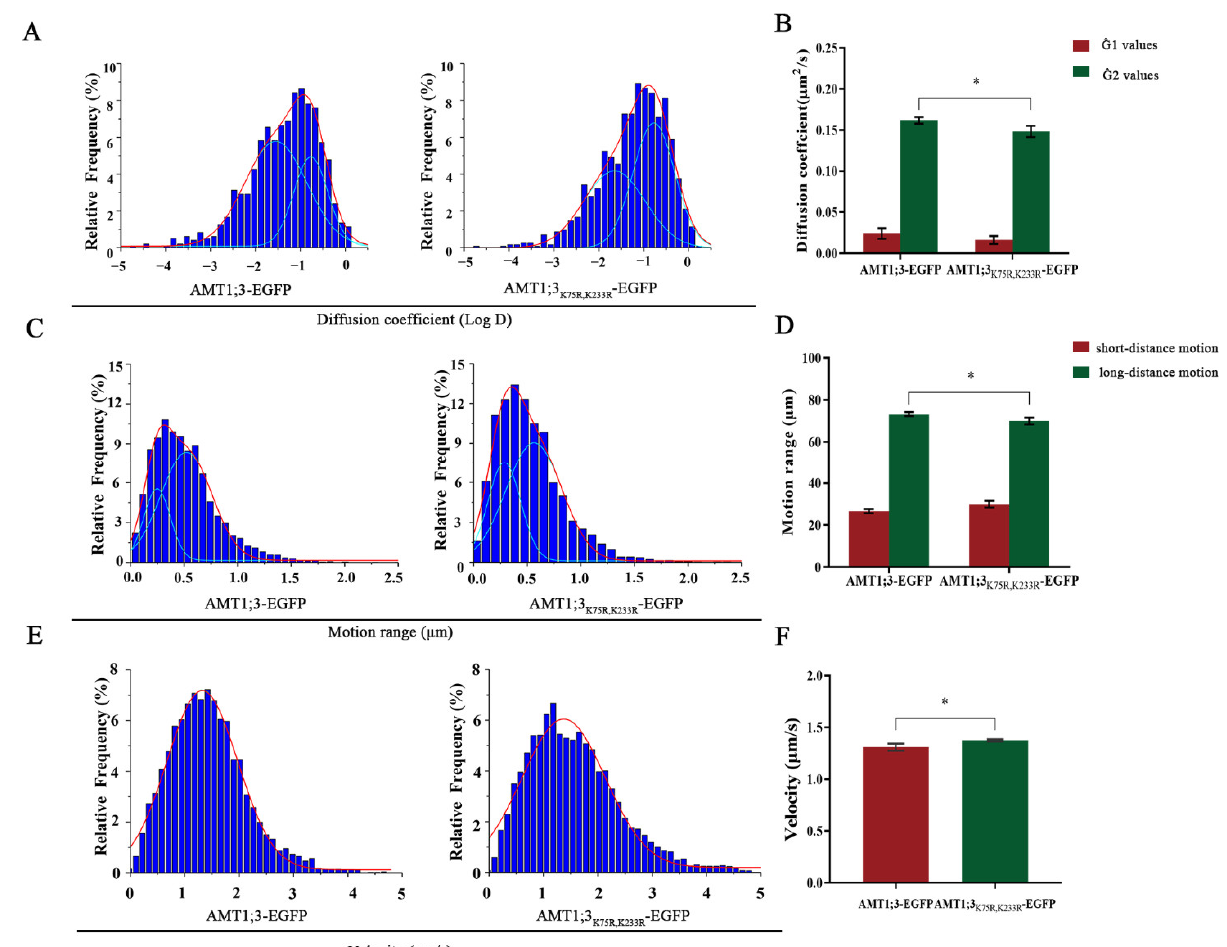
Figure 2. Ubiquitylation participates in the degradation of AMT1;3 proteins under high ammonium stress. ( A , B ) The distribution coefficient statistics of AMT1;3 and AMT1;3 K75R,K233R -EGFP proteins. ( C , D ) Motion range of AMT1;3 and AMT1;3 K75R,K233R -EGFP in Arabidopsis . ( E , F ) Distribution of AMT1;3 and AMT1;3 K75R,K233R -EGFP velocity on the cell plasma membrane. * p < 0.05, t test. Error bars represent the mean ± SD.